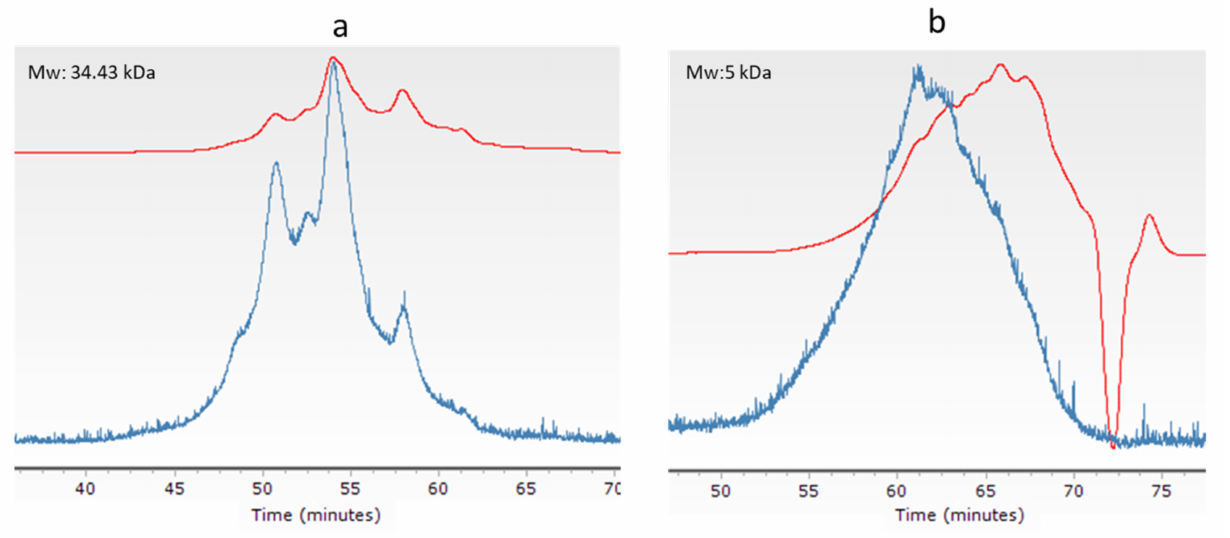
Figure 2. GPC profile of hydrolysates selected for further cell viability and mRNA type I collagen expression analysis showing their respective molecular weight: BSCH-C ( a ) and CHC ( b ). Blue line: 90 ◦ light-scattering signal (LS); red line: refractive index signal